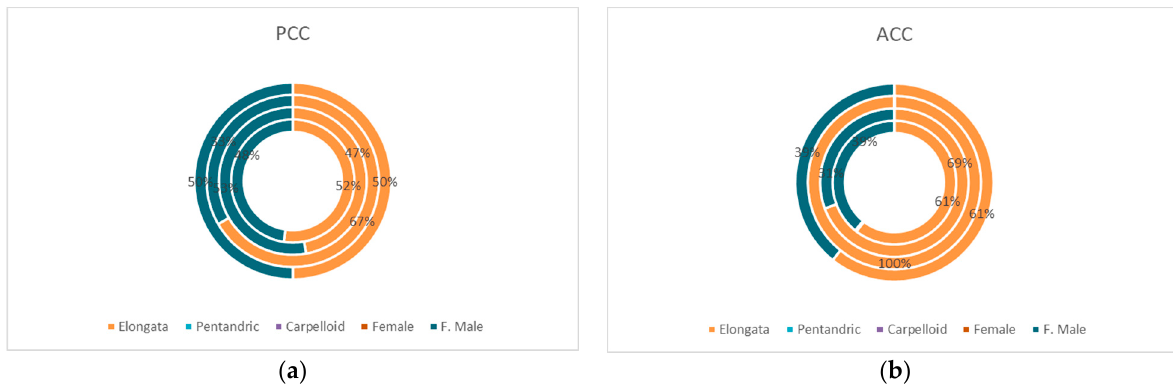
Figure 5. Seasonal frequency (%) of elongata hermaphrodite flowers (orange) that later on will produce fruits with commercial interest, and sterile, functionally male flowers (dark blue) found in “Siluet” papaya grown in ( a ) passive climate control (PCC) and in ( b ) active climate control (ACC) modules. Rings from inside to outside: autumn (November 2016), winter (January 2017), spring (May 2017), and summer (July 2017).